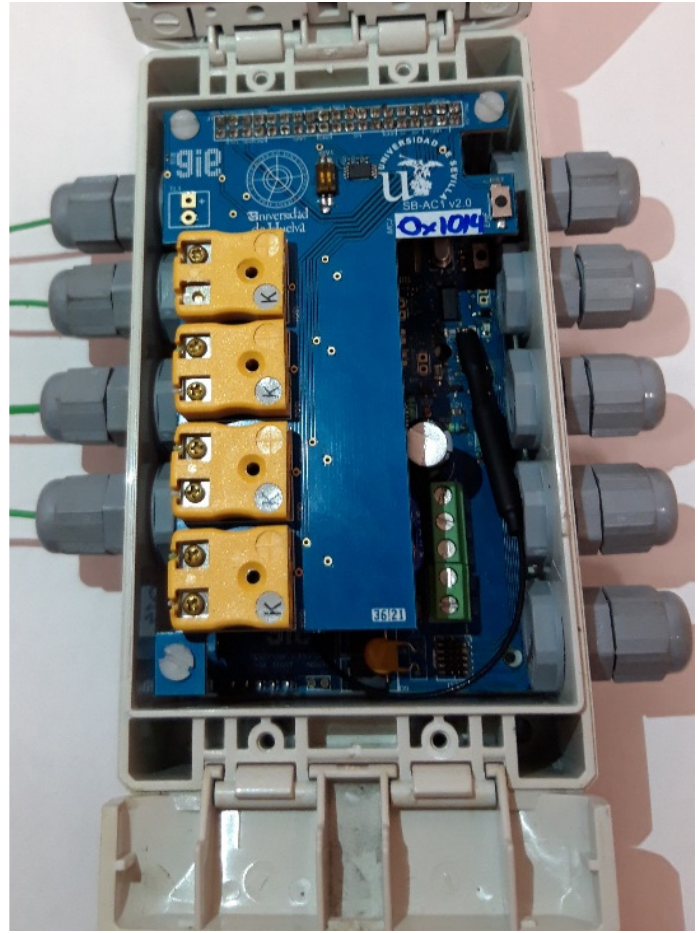
Figure 4. Packaging design.